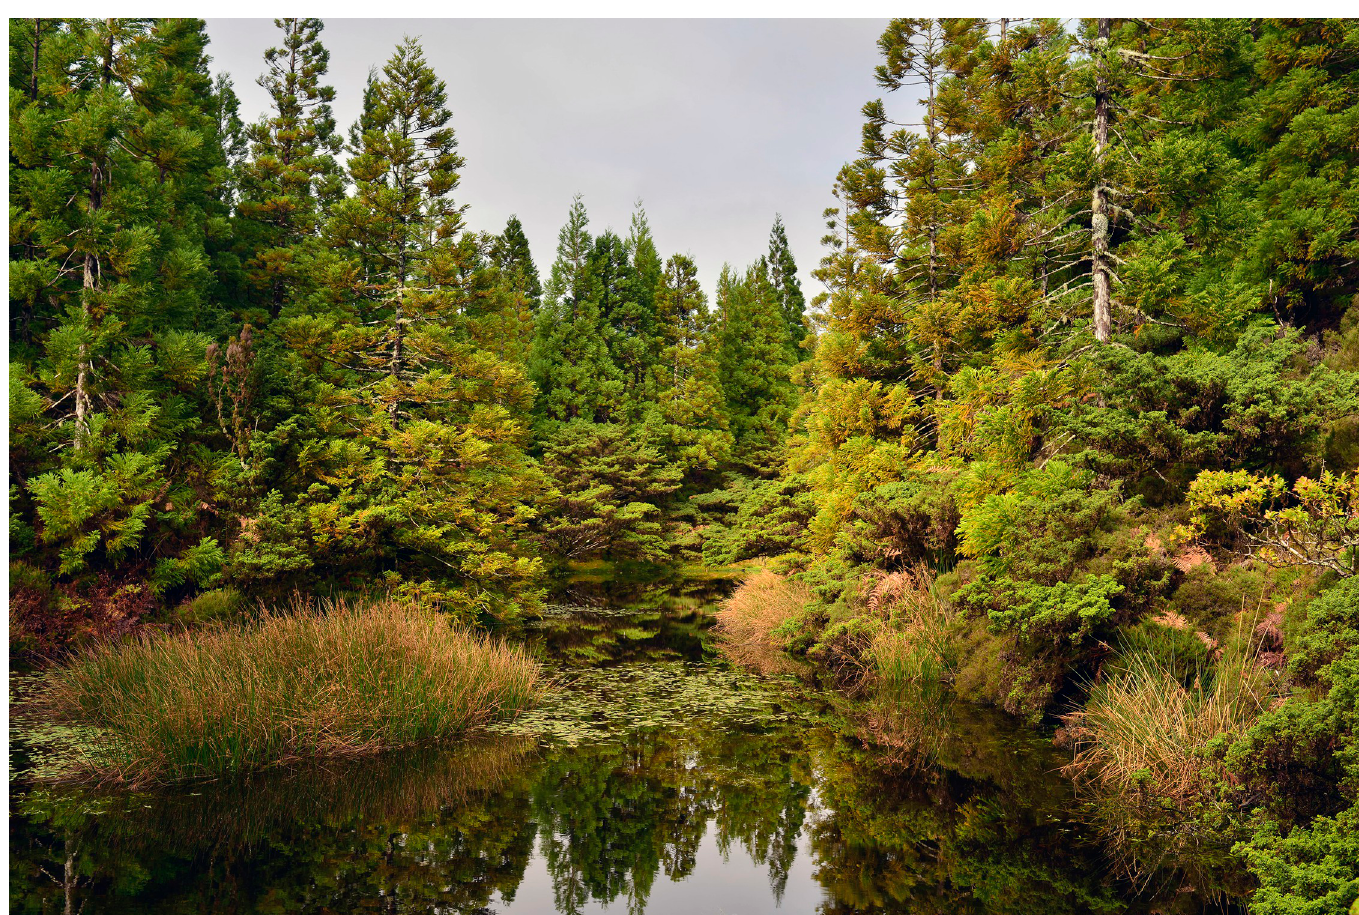
Fig 1. Natural Reserve of Serra de Santa Ba´rbara and Miste´rios Negros—Terceira’s Nature Park.